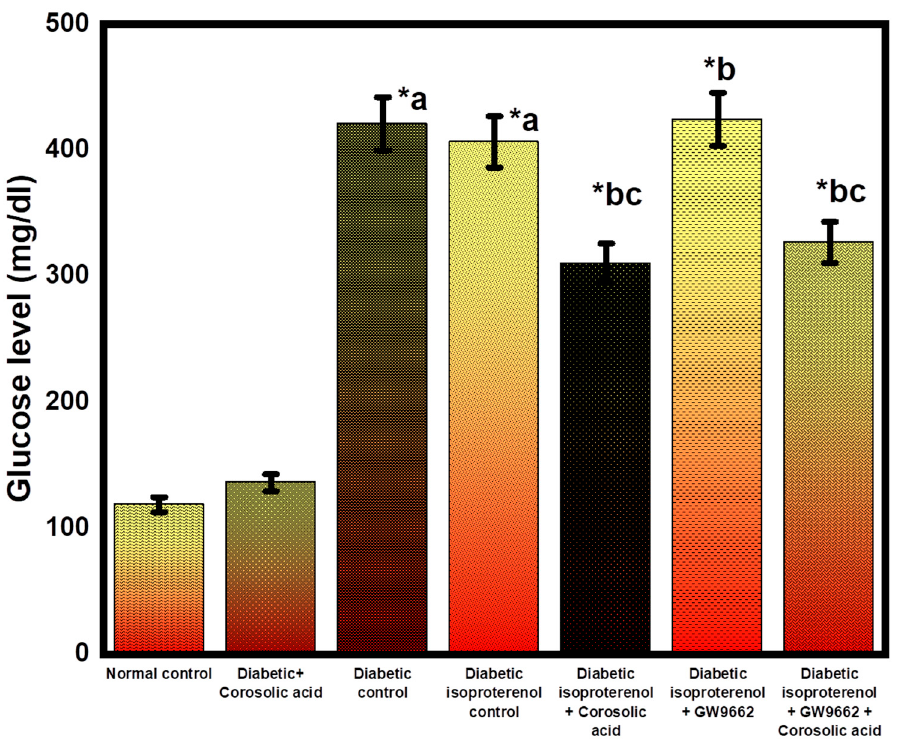
Figure 2. Effects of corosolic acid on glucose level in different groups. The data are expressed as mean ± SEM ( n = 6). * p ≤ 0.05 is considered significant. a normal control vs diabetic control and diabetic isoproterenol control; b diabetic control vs corosolic acid and GW9662 treatments; and c diabetic isoproterenol control vs corosolic acid and GW9662 treatments.